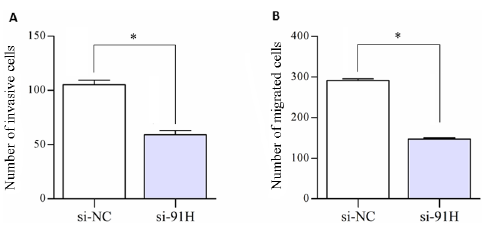
** P , 0.01). (TIF) Figure S3 HCT-116 cells were transfected with si-NC and si-91H. After 48 h, 91H expression was effectively inhibited by qRT-PCR compared with si-NC (mean ± SEM; ** P , 0.01). (TIF) Figure S4 91H promoted the proliferation of HCT-116 cells via MTT assay (mean ± SEM; P , 0.05). (TIF) Figure S5 Apoptosis was investigated using cytometric analysis at 48 h after infection with si-91H or si-NC. (TIF) Figure S6 The scratch wound assay was assessed to cell motility. The knockdown of 91H inhibited HCT-116 cell motility. (TIF) Figure S7 91H promoted invasion and migration of HCT-116 cells based on transwell assay. (TIF) Figure S8 The number of cells that invaded or migrated through the chamber was evaluated in 5 fields for each experimental group and averaged. The number of invasive or migrated cells for each experimental group was counted as the average of 5 five fields of vision under a microscope (* P , 0.05). (TIF) Table S1 Patients’ information. Table S2 The results of qRT-PCR for each sample.